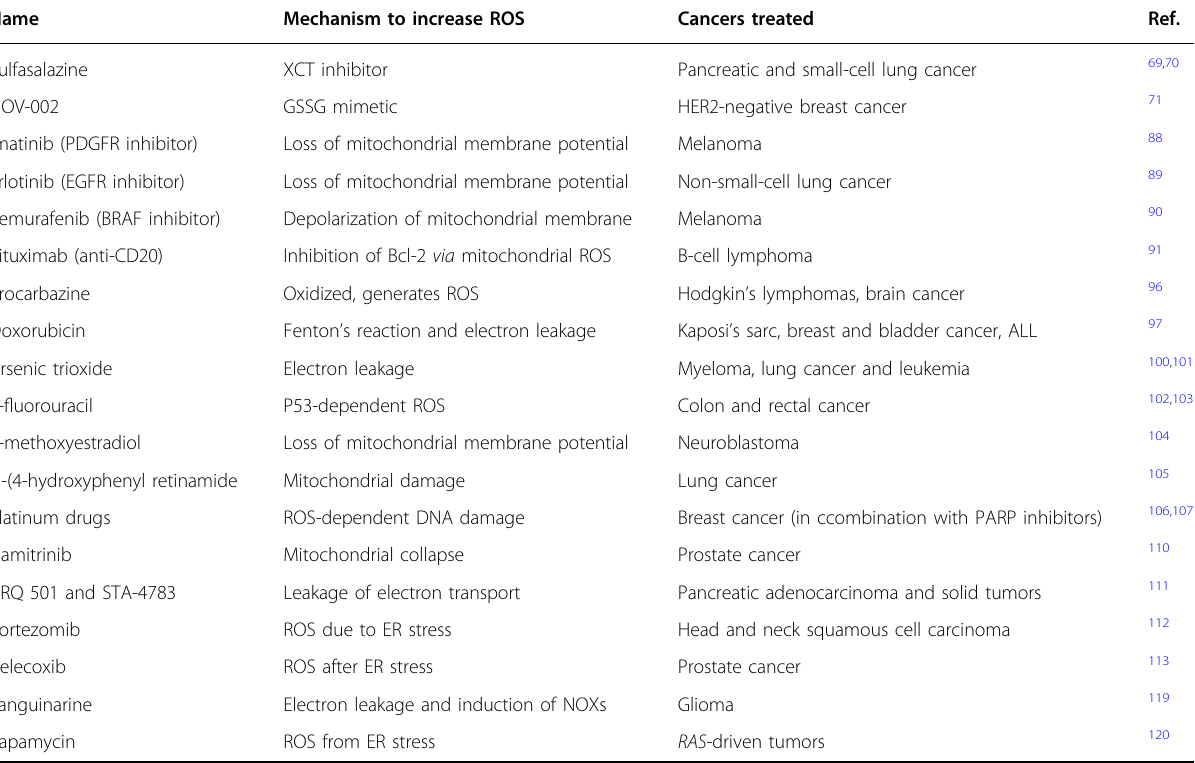
Table 1 List of anticancer drugs according to their effect on intracellular ROS, and types of cancer where are used. Name Mechanism to increase